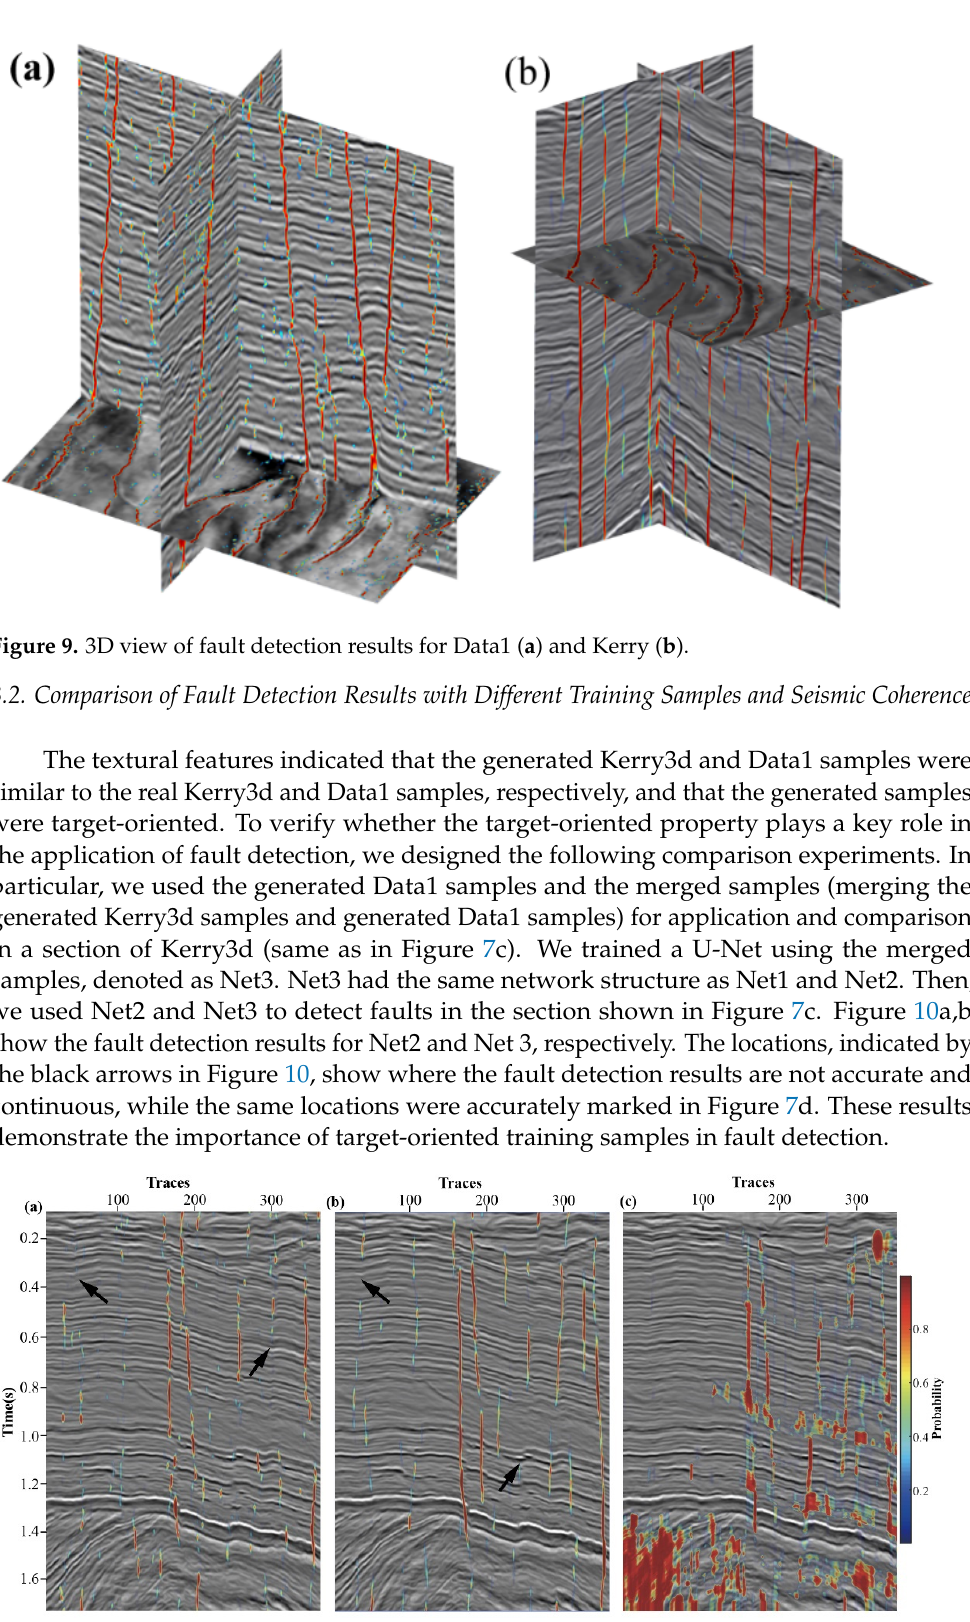
Figure 8. Fault detection test on Data1 sections: ( a ) and ( c ) two Inline sections from Data1; and ( b ) and ( d ) the corresponding prediction results.